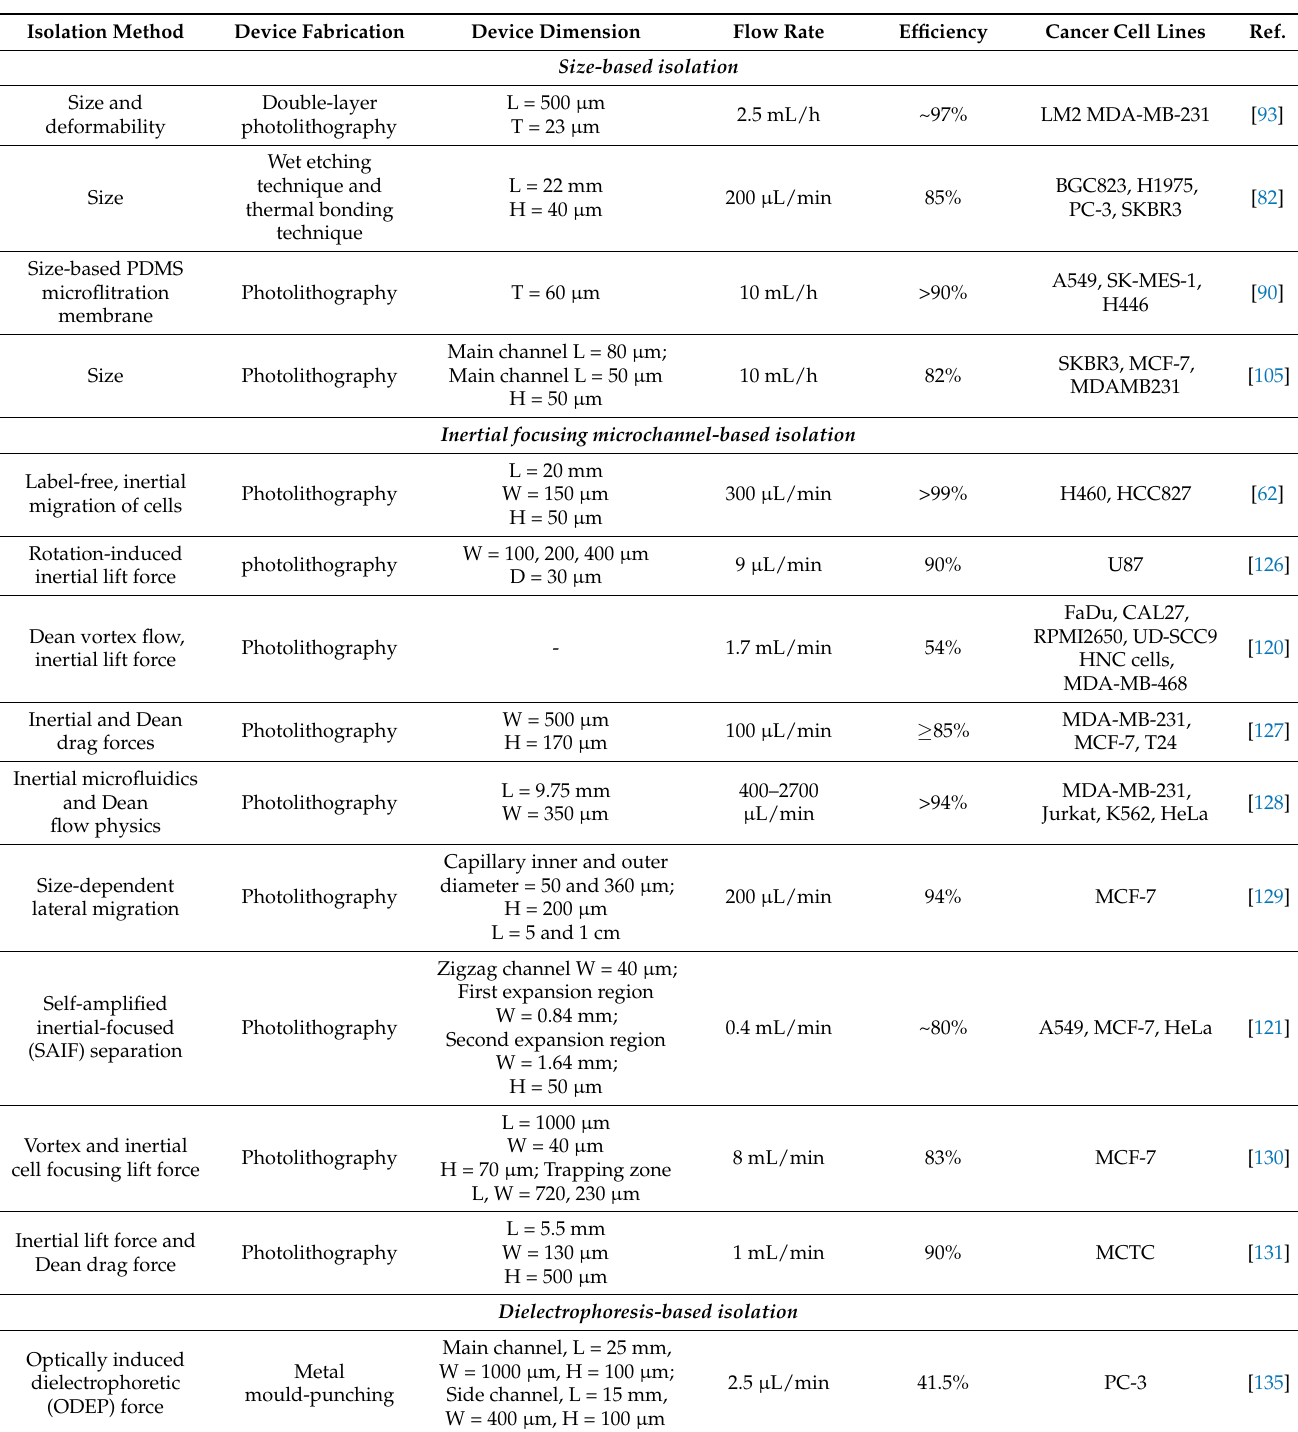
Table 1. Overview of microfluidic devices with CTC isolation mechanism, chip fabrication and other technical